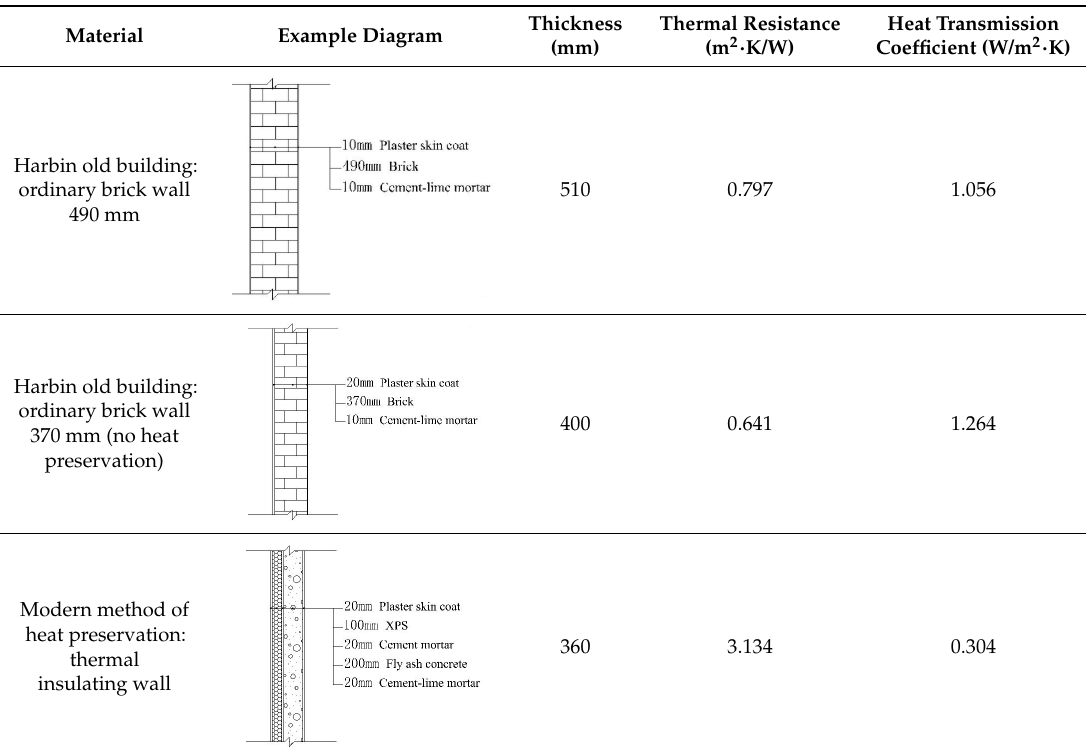
Table 2. The traditional wall and the modern wall.